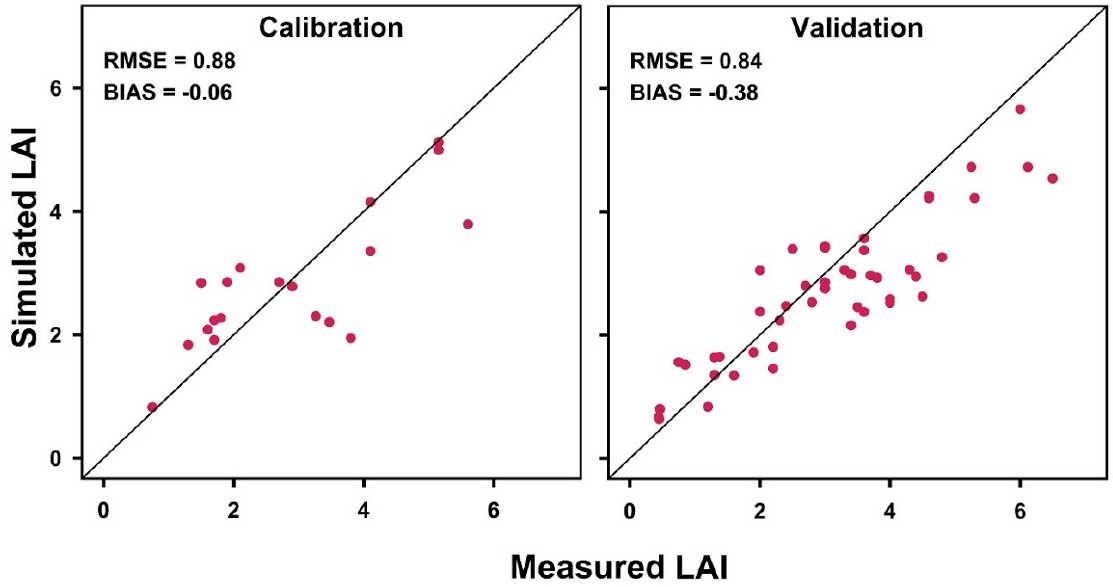
Figure A2. Calibration ( upper three panels ) and evaluation ( lower three panels ) results of the PILOTE model in Swabian Jura (SJ).